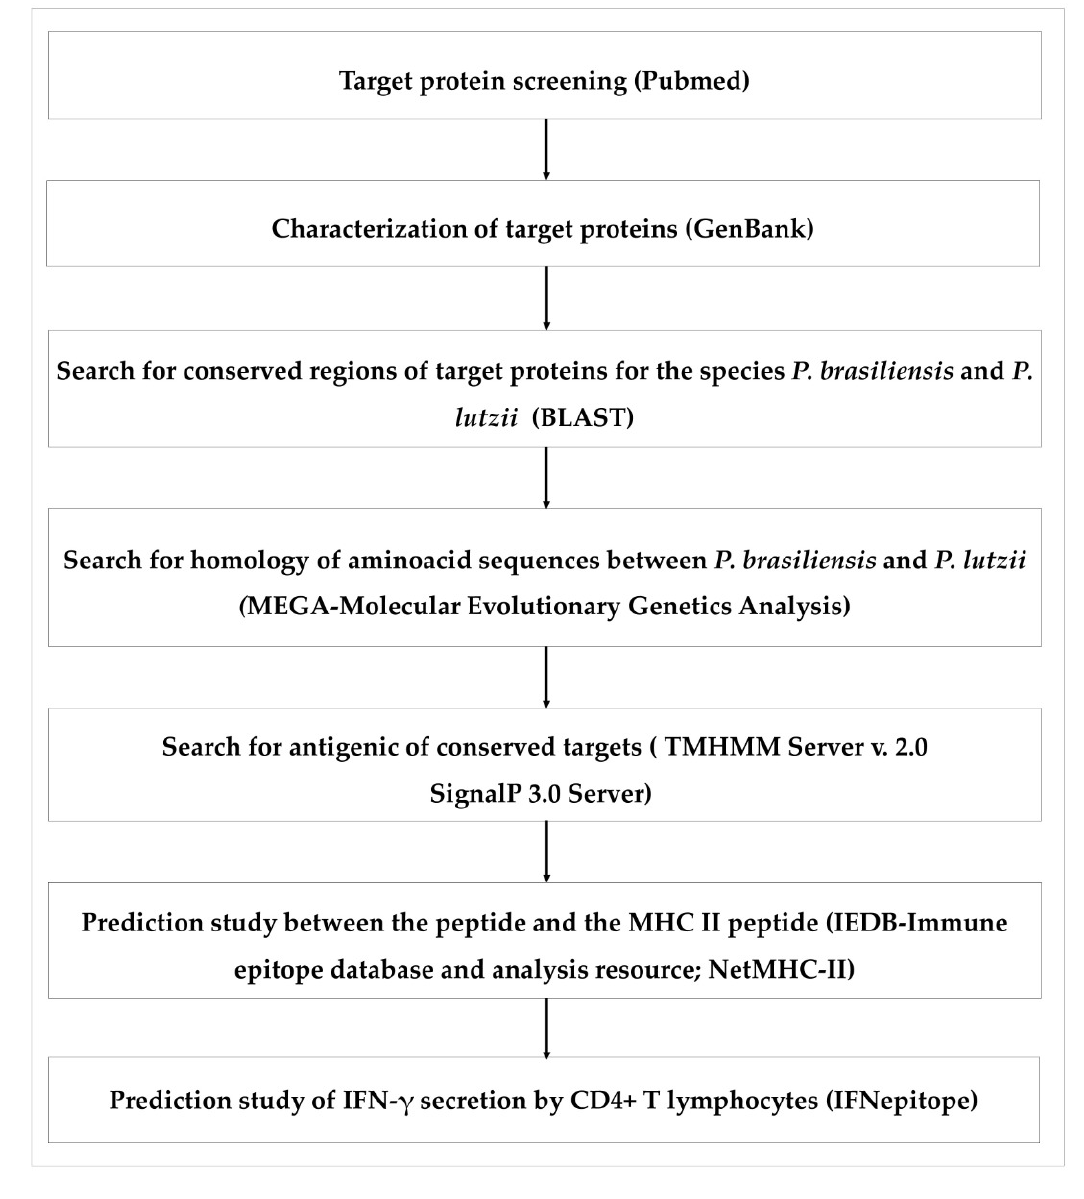
Scheme 2. Flowchart of the experimental design.